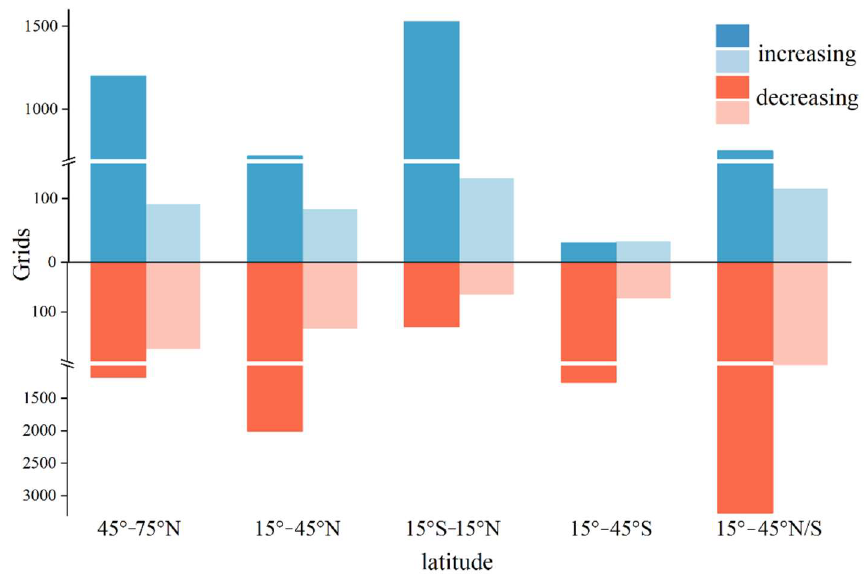
Figure 11. Significant changes in annual terrestrial water yield according to the number of grid cells in different altitude. Darker shades indicate the confirmed increasing (decreasing) trends that remains after correcting for multiple hypothesis testing ( α = 0.05), while lighter shades indicate the uncertain trends, i.e., additional significant changes that are detected when no multiple testing correction took place.